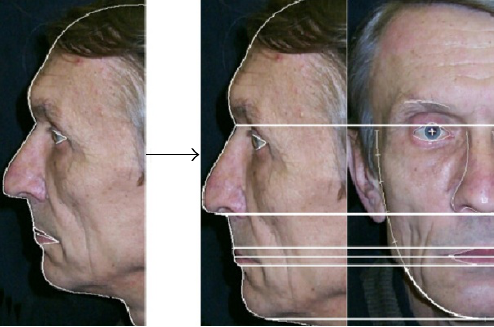
Figure 15: Local transformation on profile feature